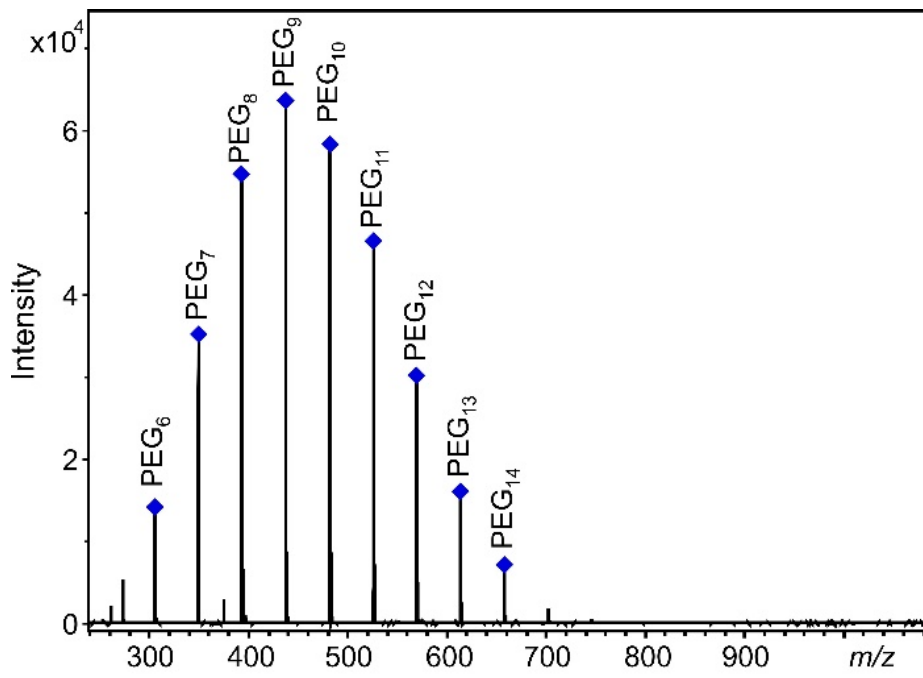
+ ionization agent.